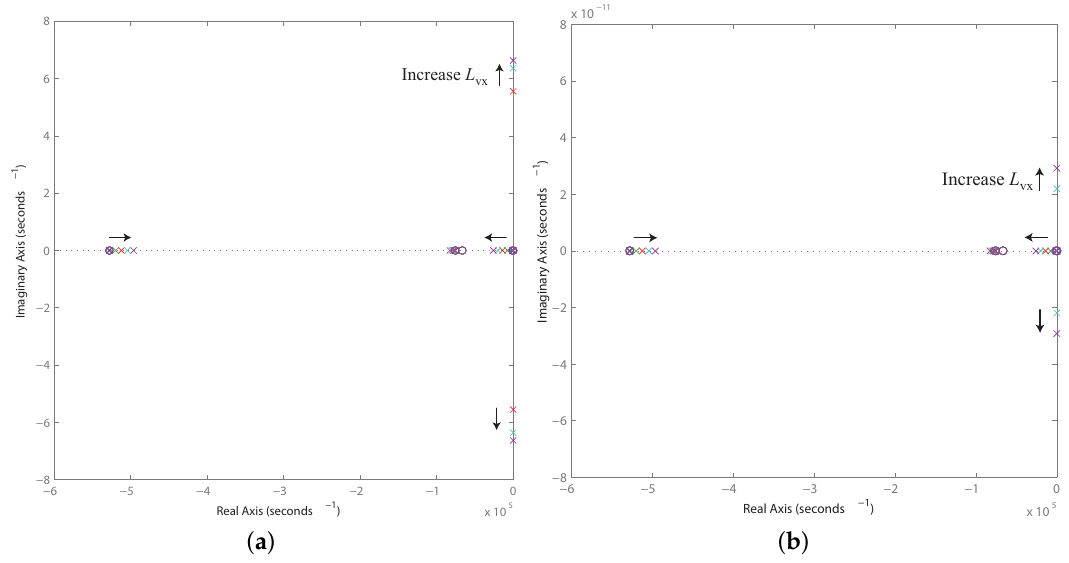
Figure 8. Pole-zero locations: ( a ) real power control; ( b ) reactive power control. Table 1. Exact pole